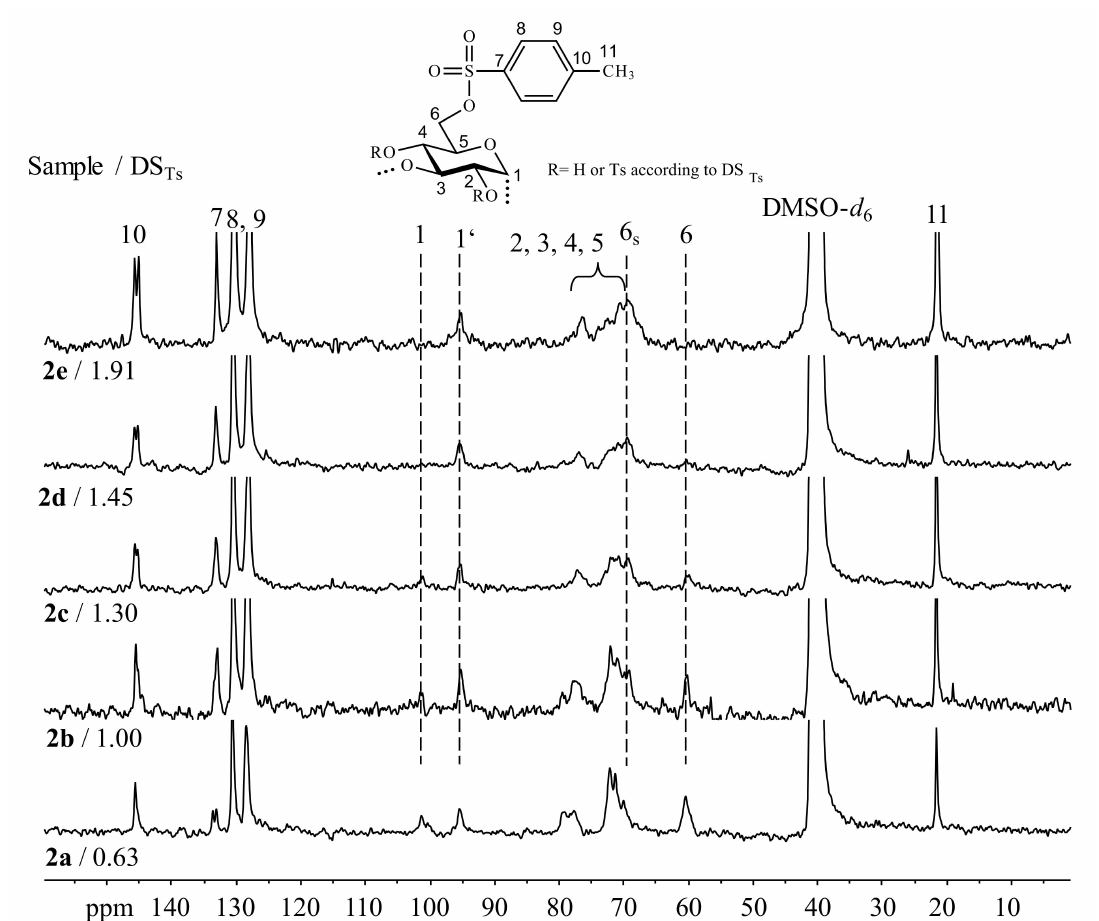
Figure 2. 13 C-NMR spectra of α -1,3-glucan p -toluenesulfonic (Ts) acid esters of di ff erent degrees of substitution of Ts groups (DS Ts ) recorded in dimethyl sulfoxide- d 6 (DMSO- d 6 ). Index s means functionalized position. Dash (‘) means influenced by functionalization of the neighboring